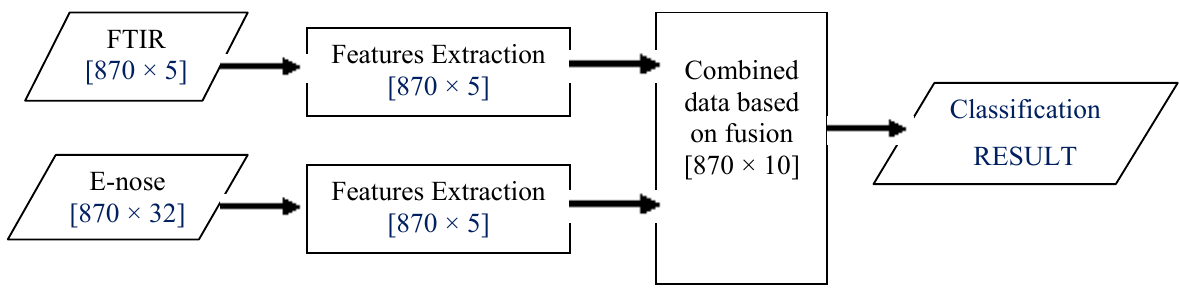
Figure 5. Intermediate-level or feature-level fusion